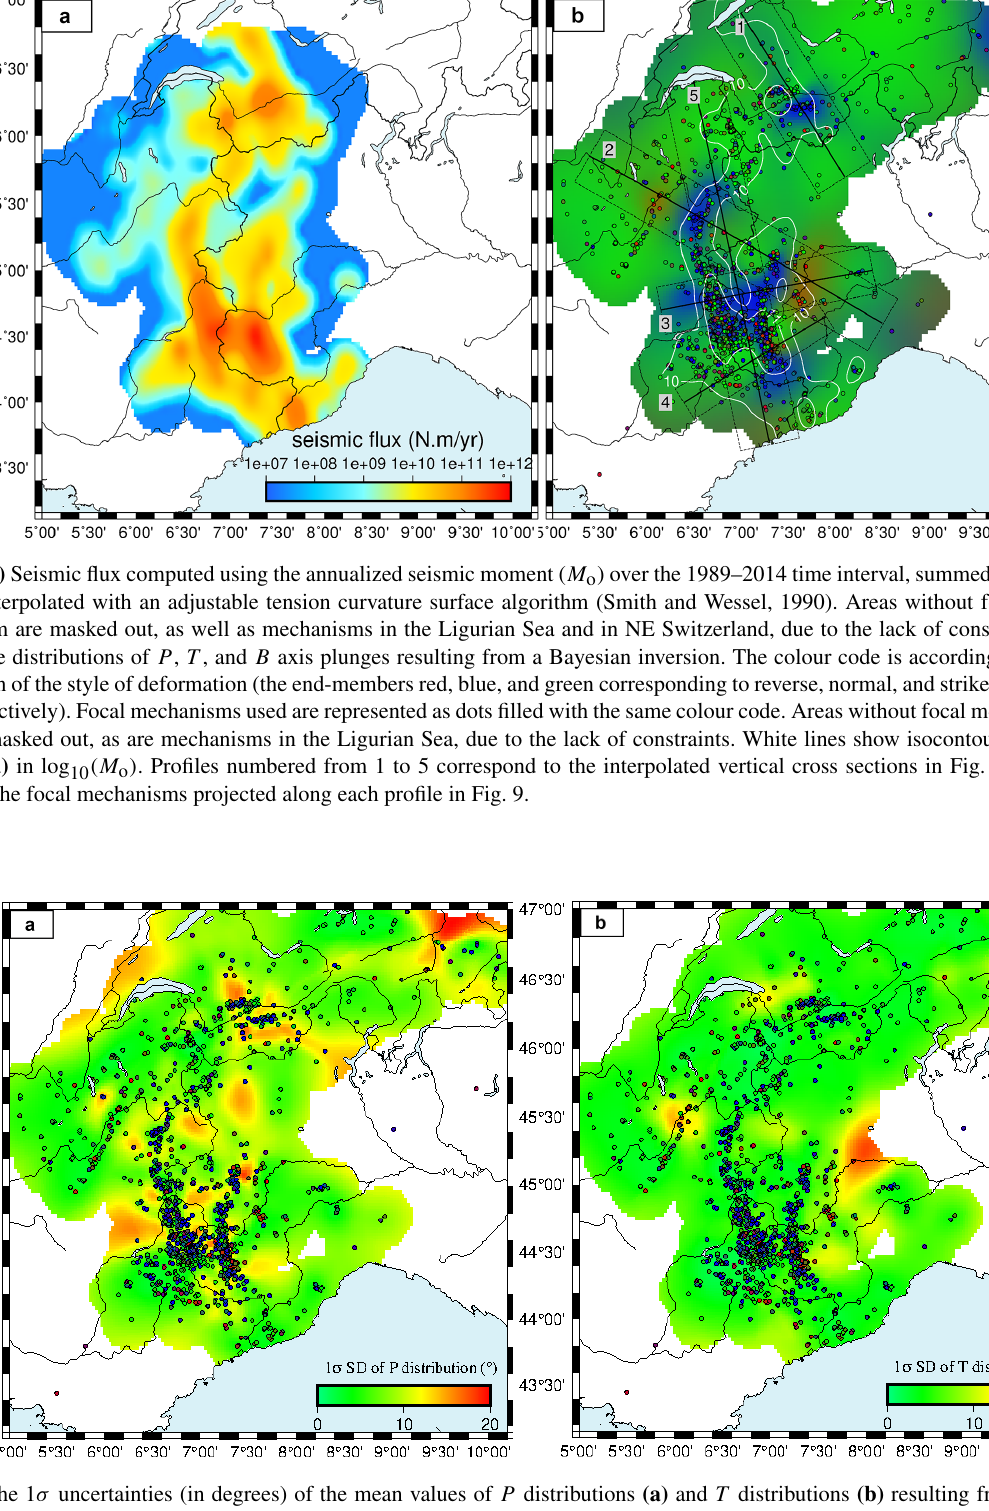
Figure 8. The 1 σ uncertainties (in degrees) of the mean values of P distributions (a) and T distributions (b) resulting from the Bayesian interpolation in Fig. 7. Superimposed focal mechanisms allow us to distinguish between two types of higher-uncertainty areas: areas without enough data and areas displaying high data